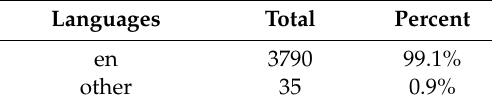
Table A27. Primary languages (ie).